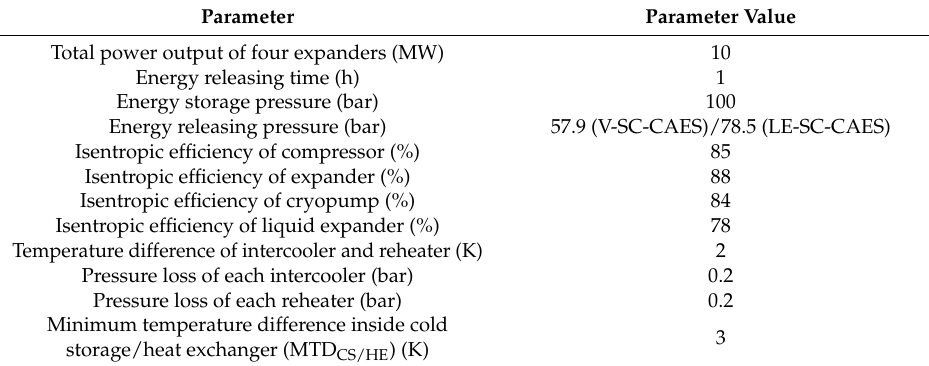
Table 4. Basic simulation parameters [45].